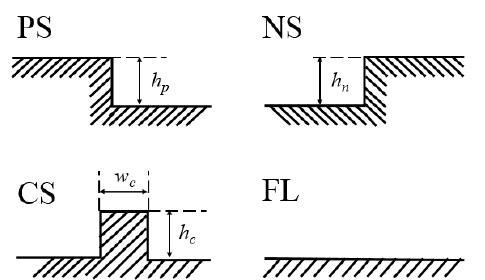
Algorithm 1 NS classifying algorithm